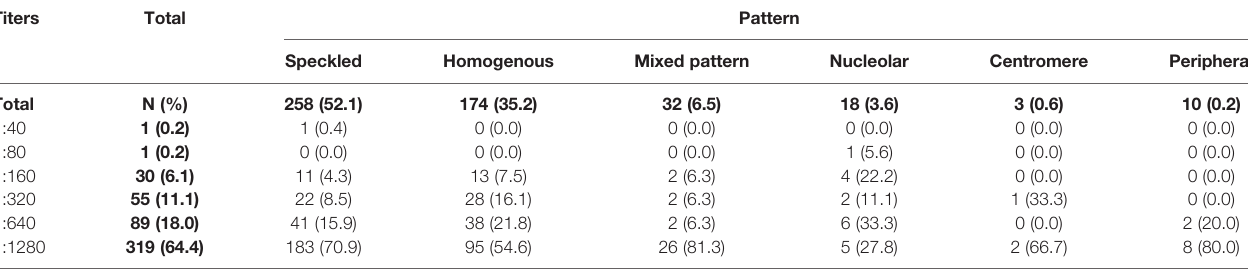
TABLE 3 | Titers and patterns of antinuclear antibodies in SLE patients. Titers Total Pattern Speckled Homogenous Mixed pattern Nucleolar Centromere